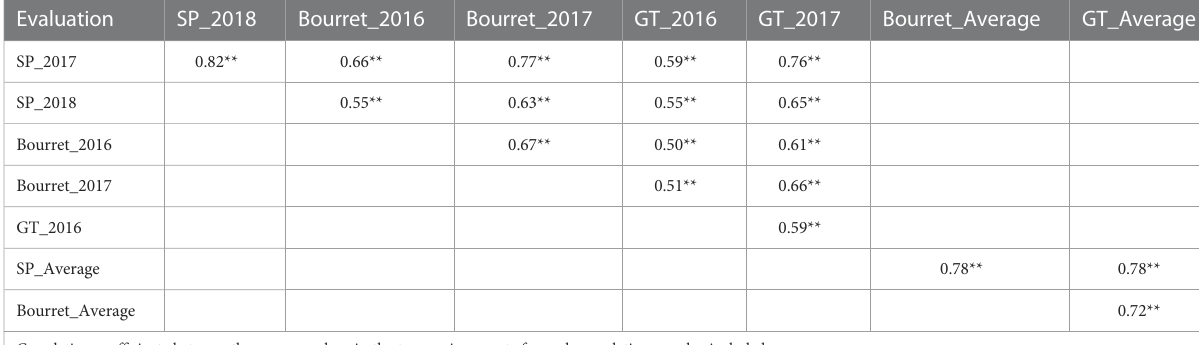
TABLE 3 Correlation coef fi cients between emerged broomrape shoots in a set of 104 sun fl ower accessions evaluated with three broomrape populations in two environments each one. Evaluation